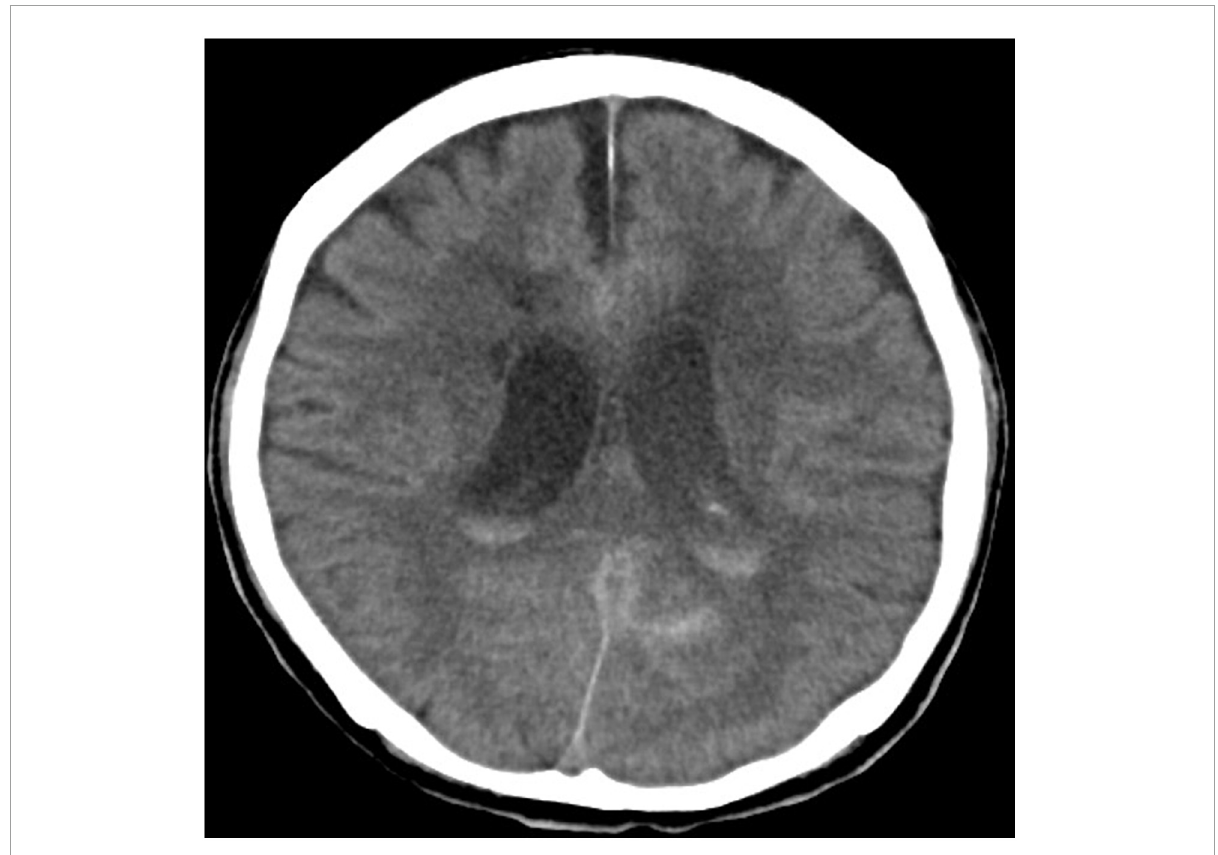
FIGURE2 Computed tomography brain showing intraventricular extension leading to